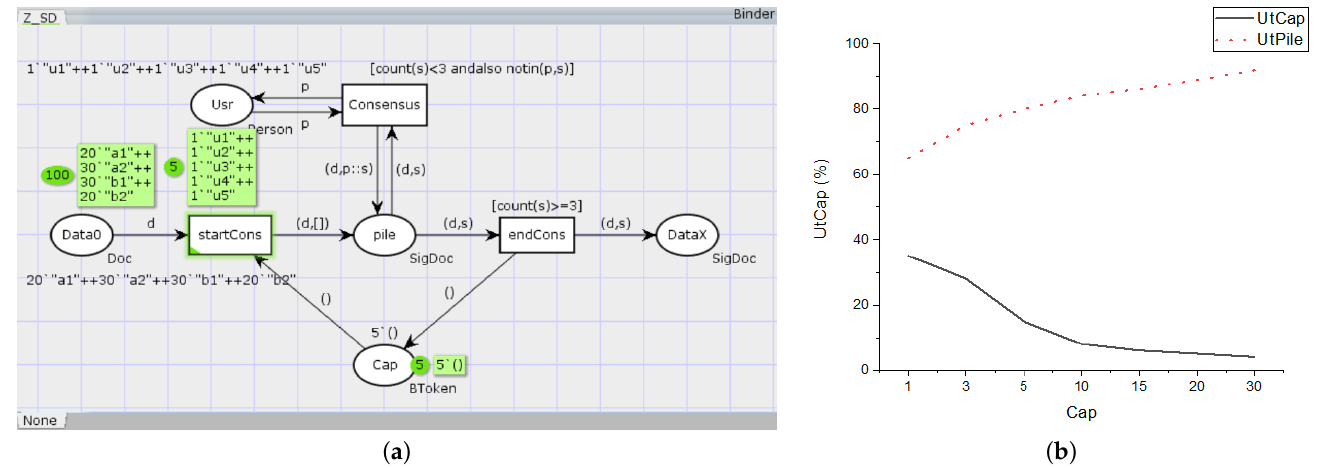
Figure 5. Behavior and metrics statistics for data access. ( a ) CPN Model. ( b ) Data Statistics. The initial data Data0 is stacked in the buffer Pile after entering the consensus